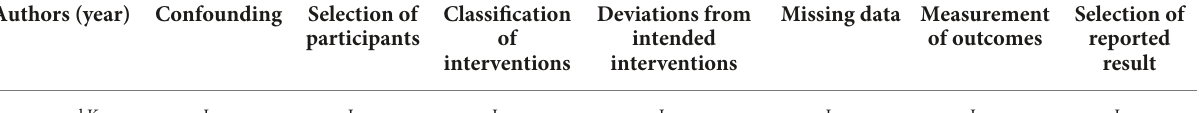
TABLE 3 Quality appraisal for non-randomized trials.